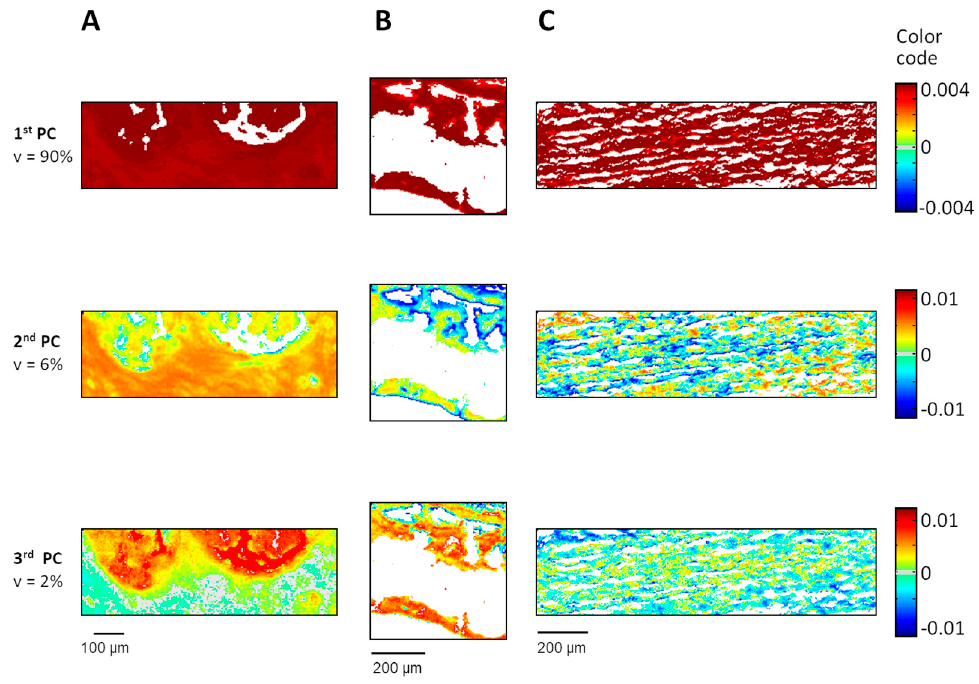
Figure 8. Results of PCA of the spectroscopic data set showing score images of ( A ) mineralized aortic valve leaflet, ( B ) mineralized AV prosthesis and ( C ) non-implanted prosthesis. Score images are printed in the rainbow colour code where blue colours represent low values and red colours high values. Gray pixels indicate a score value of zero, and white pixels represent spectra that were not involved in PCA. The percentage values display the amount of variance covered by the particular PC.